Question: Provide a one-line summary of what is displayed.
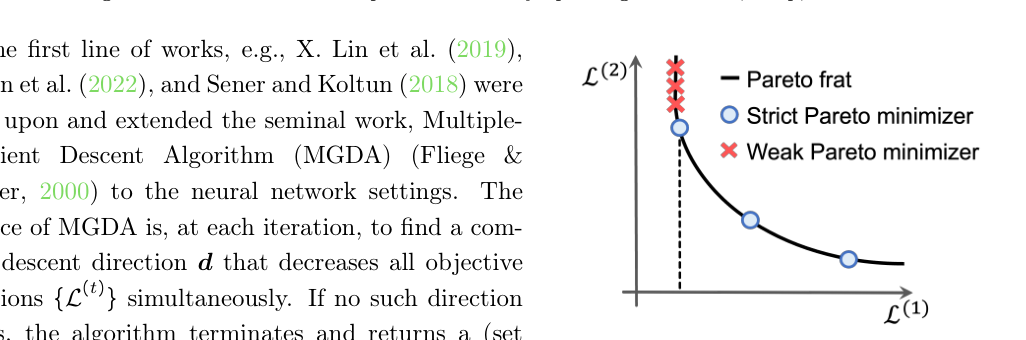
Answer: An illustration of weak and strict Pareto minimizers and Pareto front. We emphasize that the circles and crosses on the curve are NOT weak and strict Pareto minimizers. Instead, those W ∗s that generate circles and crosses are weak and strict Pareto minimizers, respectively. In this figure, all cir- cles and crosses are Pareto station- ary points. We remark that in this example, the Pareto front is convex and continuous. The Pareto front can also be non-convex and/or dis- continued, for example, see S. Liu and Vicente (2020, Page 12).